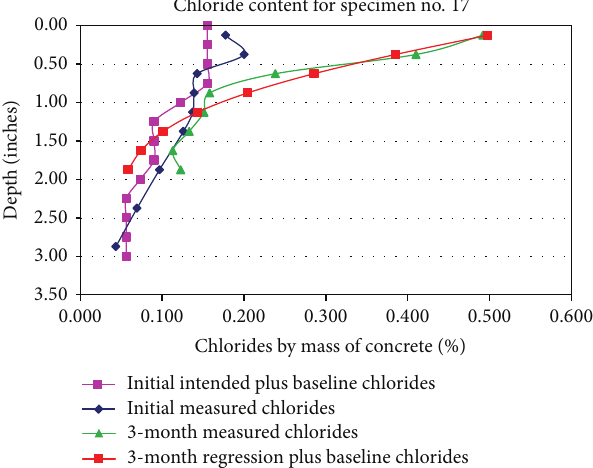
Figure 9: Comparison of initial and 3-month chlorides for speci- men number 17.